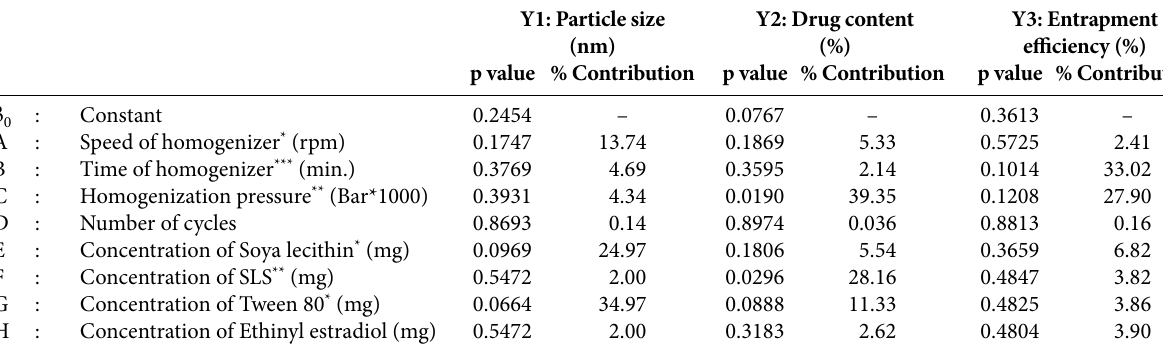
Table 6. ANOVA analysis for response variables in Plackett – Burman design